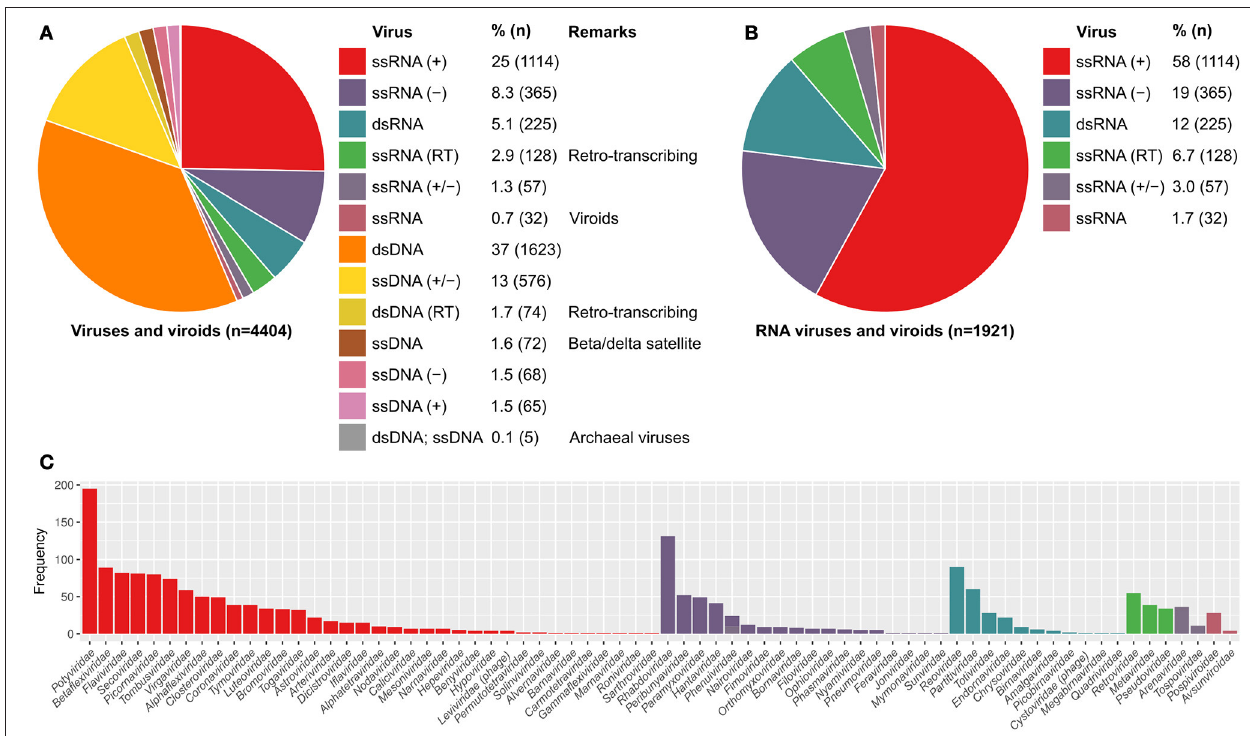
FIGURE 4 | Proportion of known viruses and viroids based on the Baltimore classification, used in the ICTV database. (A) The genetic material of about 44% of known viruses and viroids is RNA. (B) About 58% RNA viruses and viroids are positive strand RNA viruses [ssRNA ( + )] of which (C) Potyviridae are the largest family. RNA viruses are usually enriched with RNA structures. This is partly due to both the replication and transcription of eukaryotic RNA viruses occur in the cytoplasm, which are distinct from the host system and are driven by viral RNA elements. RNA virus transcripts therefore lack 5 ′ -m 7 G-cap and are translated via unusual mechanisms such as internal ribosome entry site (IRES)-mediated translation and cap-independent translation. Only two RNA virus families are bacteriophages, namely Leviviridae and Cystoviridae , which are positive-sense single-stranded RNA and double-stranded RNA viruses,